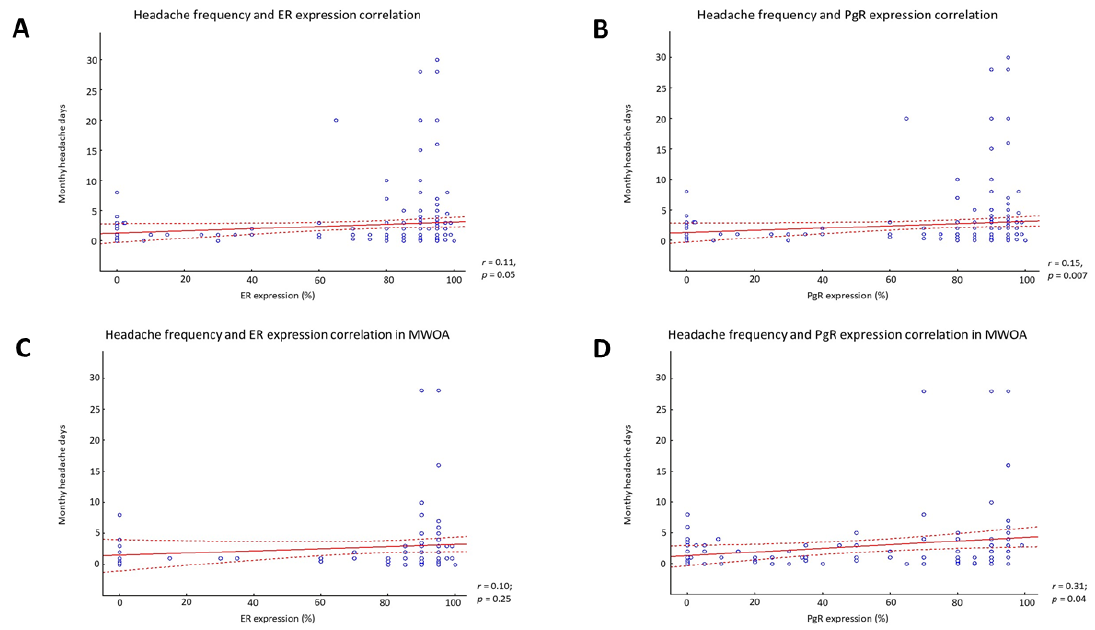
Figure 1. Headache frequency in relation to ER and PgR expression in all headache subgroups ( A , B ), respectively and in MWOA ( C , D ), respectively. Blue circles represent individuals (subjects may be overimposed). The continuous red line represents the correlation line and the dotted red lines the ± 95% CI of the correlation value.